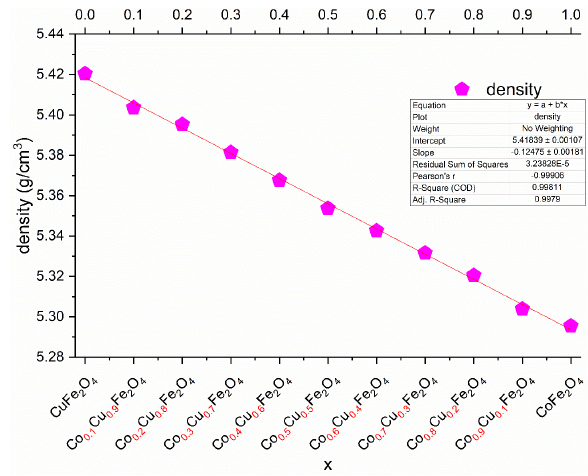
Figure 6: Density of Co x Cu 1-x Fe 2 O 4 solid